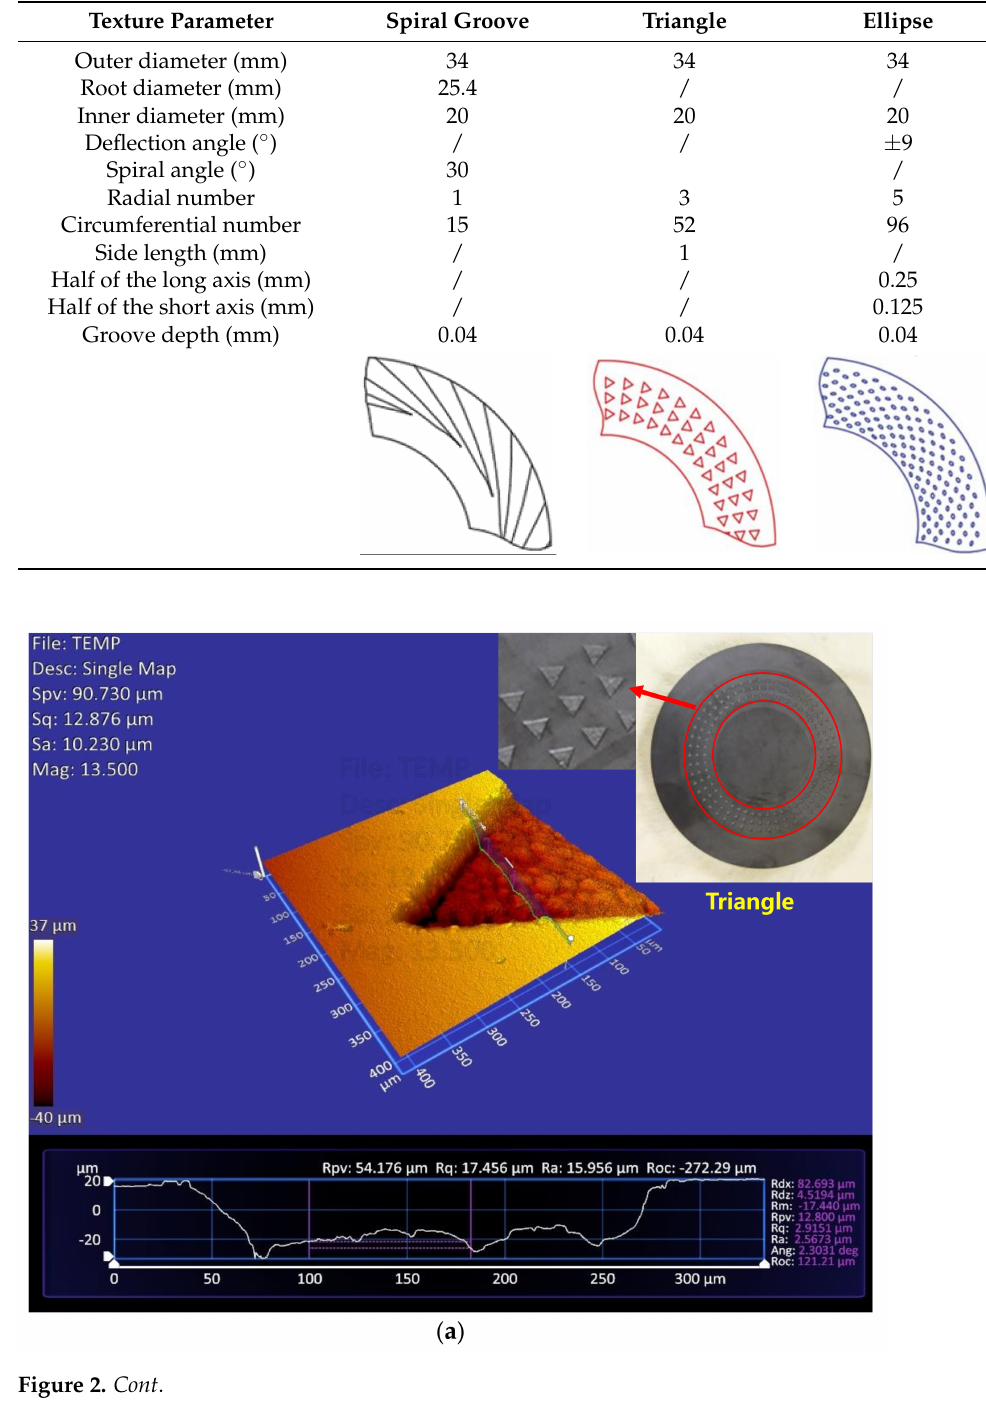
Table 2. Geometry parameters of triangle, ellipse, and conventional spiral groove texture